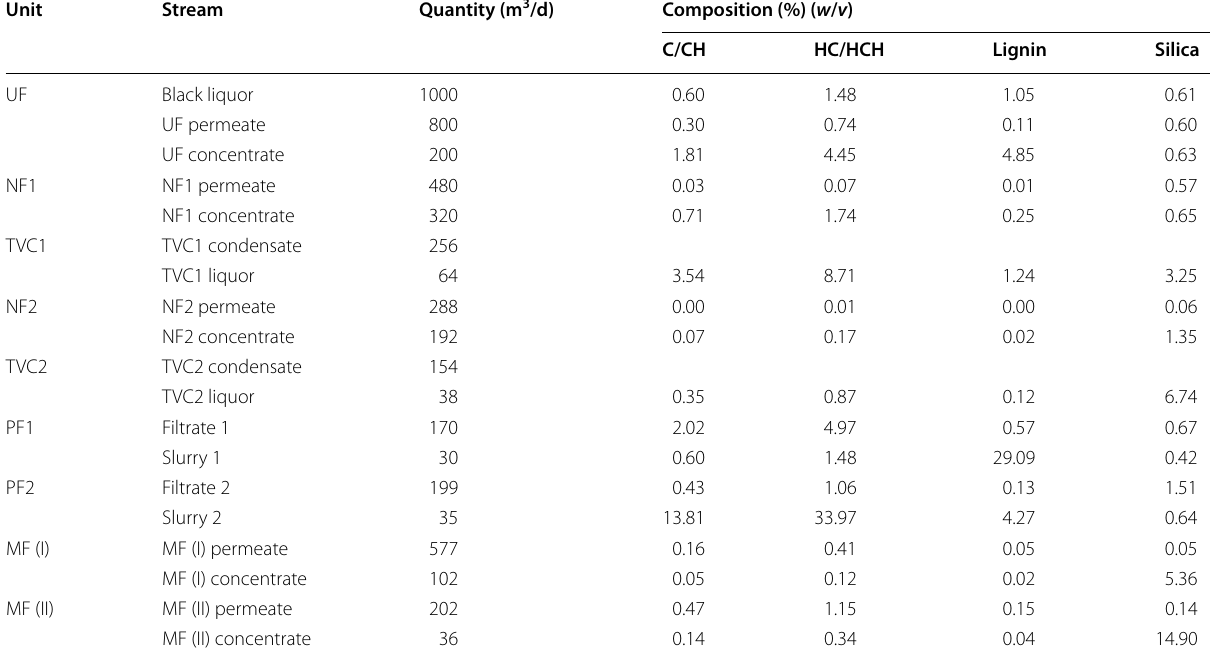
Table 2 Stream’s quantities and composition in the developed schemes Unit